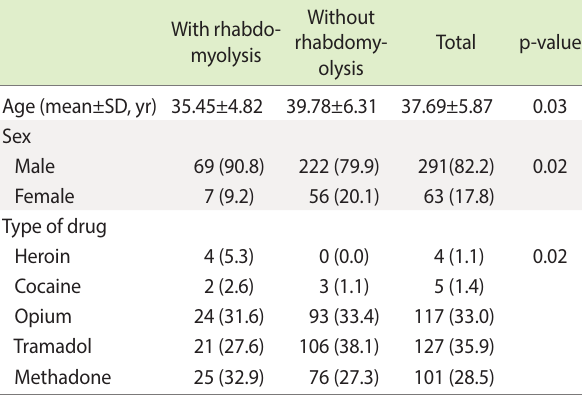
Table 1. Comparison of the characteristics of the patients with and without rhabdomyolysis With